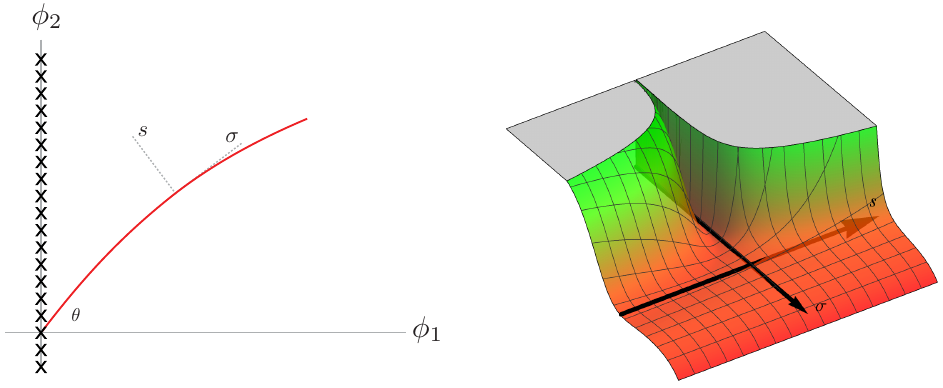
Figure 1 . Left : trajectory (red line) in two-field inflation in the neighbourhood near a singularity curve (dark crosses). Right : typical pole-induced inflationary potential: a narrow flat valley in canonical